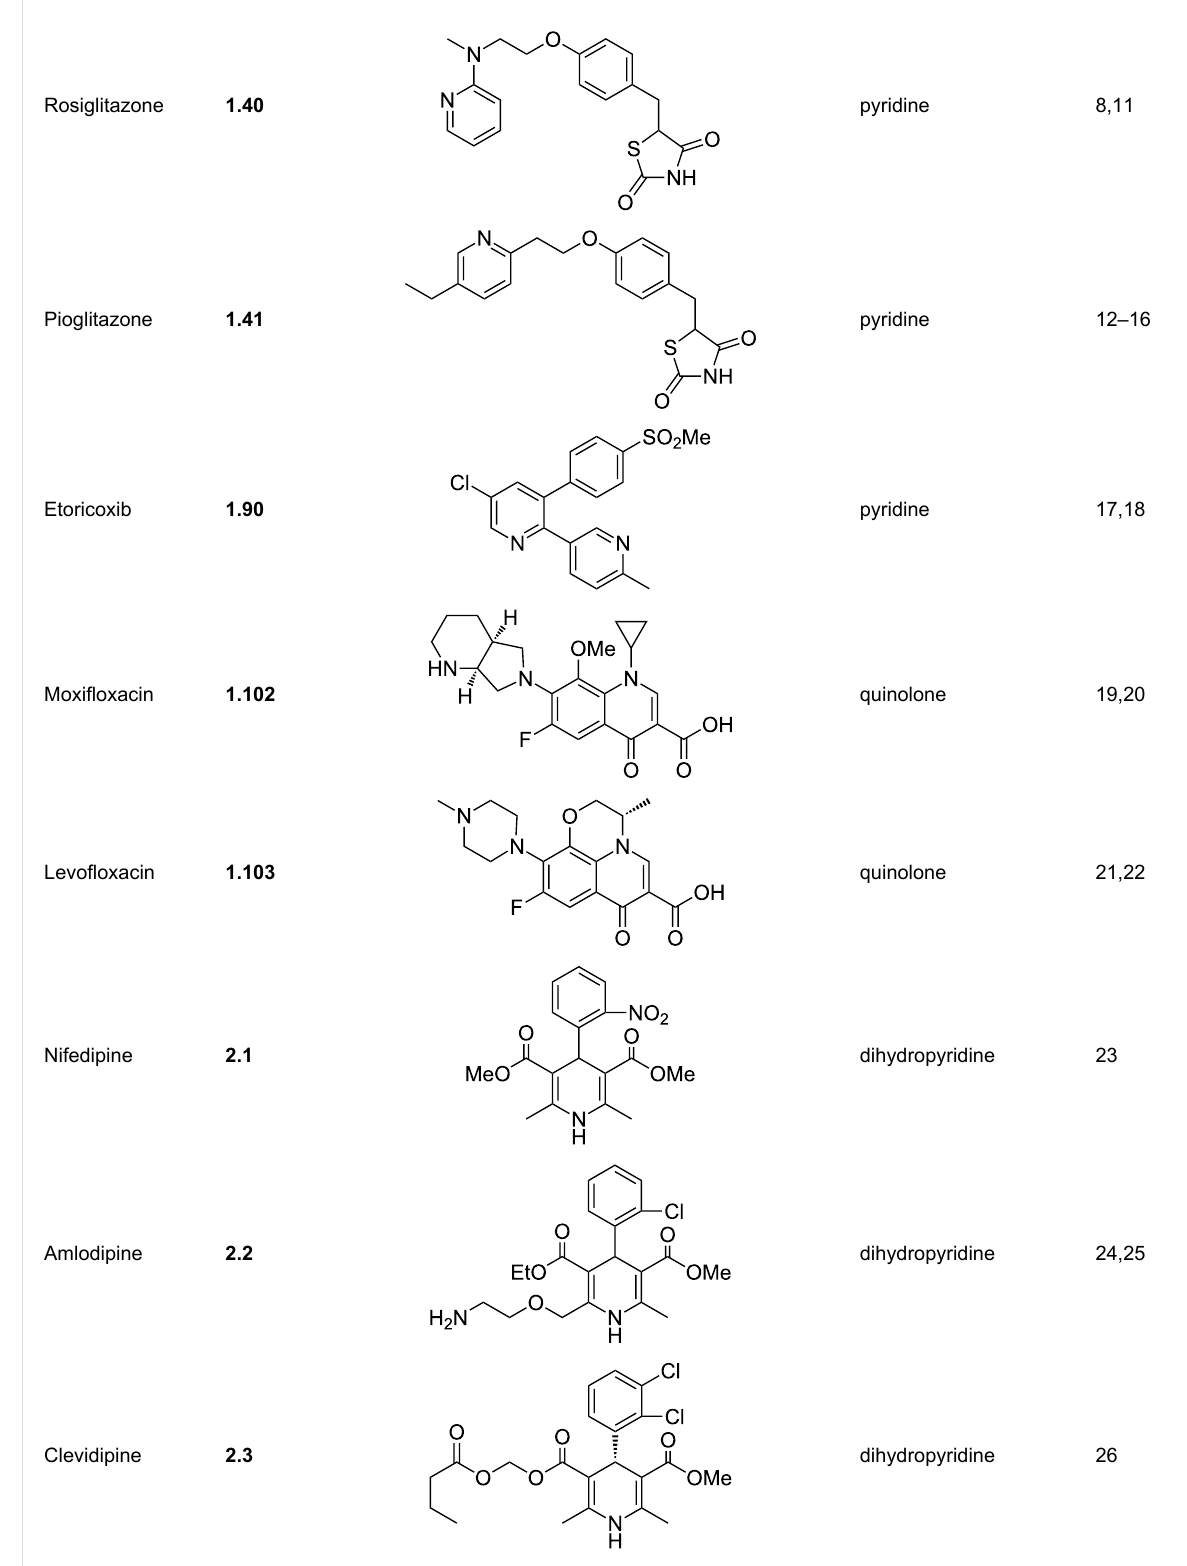
Table 1: Chemical structures of the heterocyclic compounds discussed in this review. (continued)